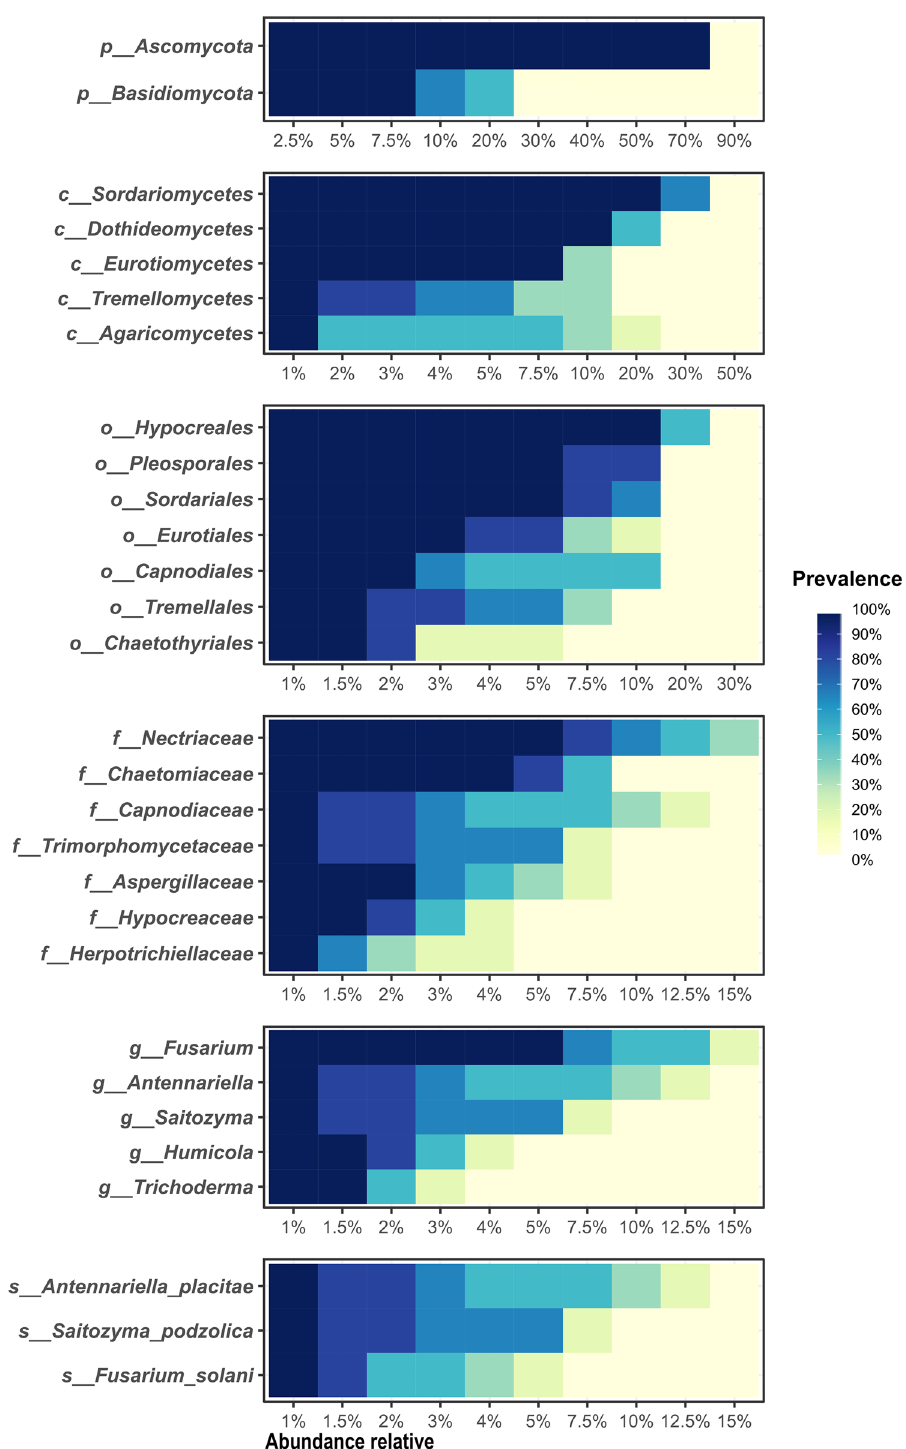
Figure 7. Core rhizosphere sugarcane microbiome analysis. High prevalence fungal taxa (> 90%) in the rhizosphere samples, regardless of the farming system, where the blue color indicates the prevalence of taxa in the samples and the horizontal percentage represents the relative abundance of each taxon in the respective sample. The taxonomic level can be identified by the prefixes: “p” (phylum), “c” (class), “o” (order), “f” (family), and “g”